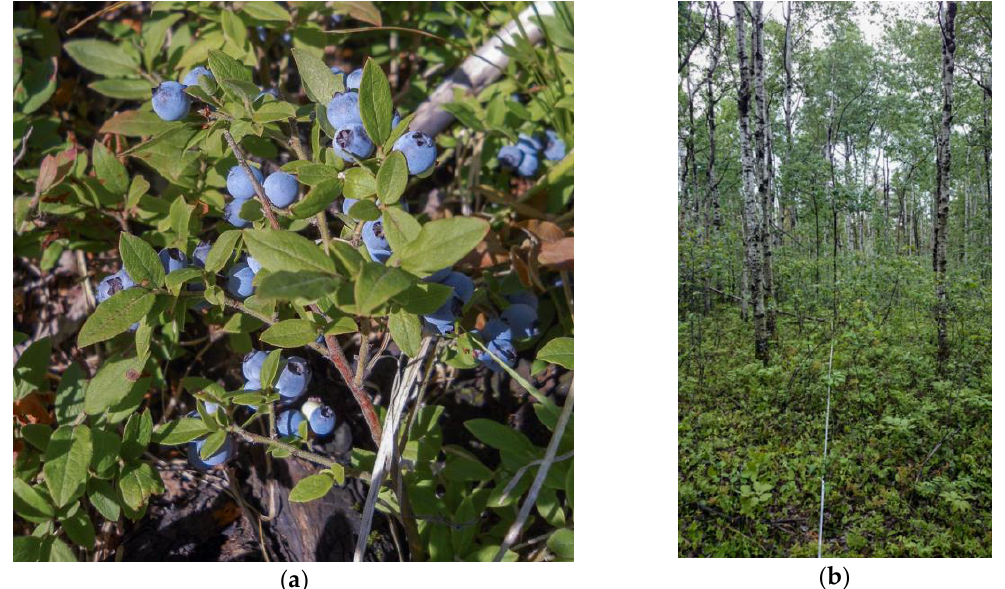
Figure 1. ( a ) Velvet-leaf blueberry ( Vaccinium myrtilloides Michaux) with ripe fruit from northeast Alberta, Canada; ( b ) example habitat where blueberry is abundant in the understory, here in a semi- open dry aspen forest (note transect line). Photographs by S.E. Nielsen.